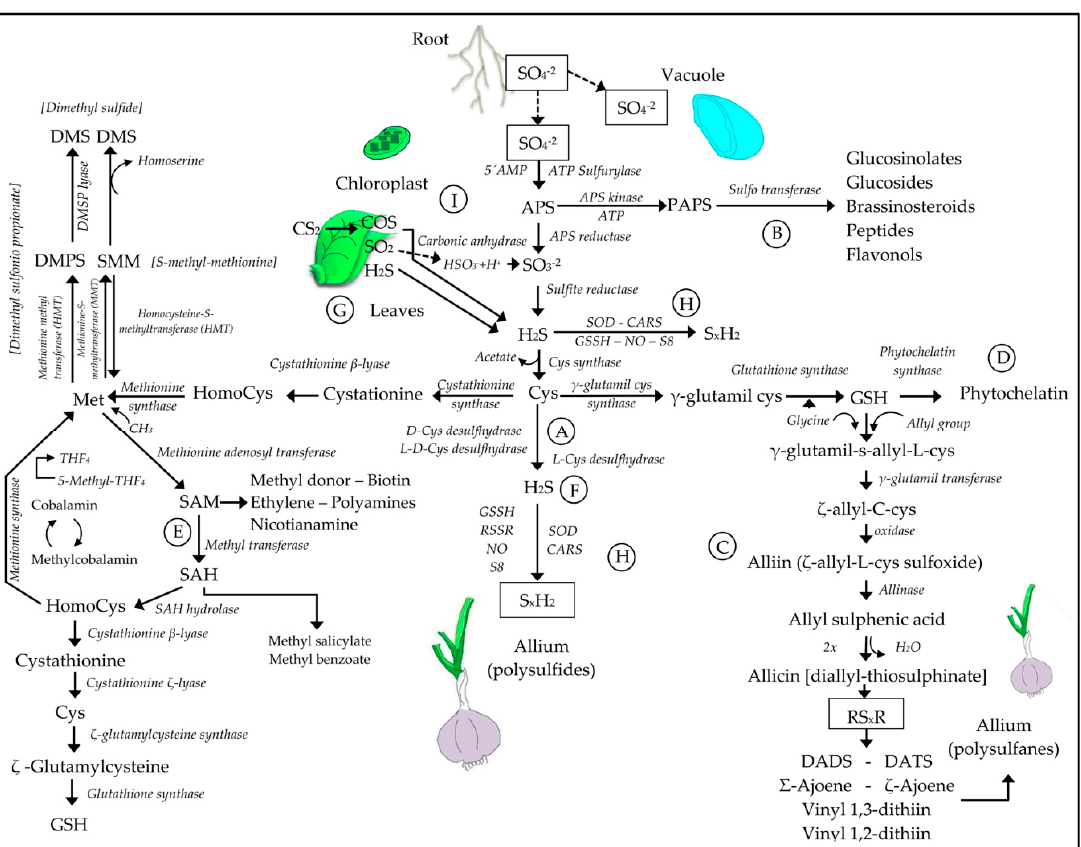
Figure 4. Schematic representation of the primary and secondary pathways of sulfur assimilation. In the primary assimilation pathway ( A ), APS is reduced to SO 3 and subsequently to S 2 − /H 2 S, which are assimilated to form the amino acid cysteine [68,71]. In the secondary pathway ( B ), SO 4 is phosphorylated and converted to 3 ′ -phosphoadenosine 5 ′ -phosphosulfate (PAPS) [48,68]. Cysteine is a central point for the synthesis of methionine or the production of polysulfanes ( C ), polysulfides ( H ), phytochelatins ( D ), SAM ( E ), and H 2 S ( F ) [48,68,72–75]. The absorption of sulfur in its gaseous forms is carried out by the stomatal route, directly incorporated into the primary pathway (SO 2 and H 2 S) ( G ) [68], or through the action of carbonic anhydrase (COS) ( I ) [69,70] .